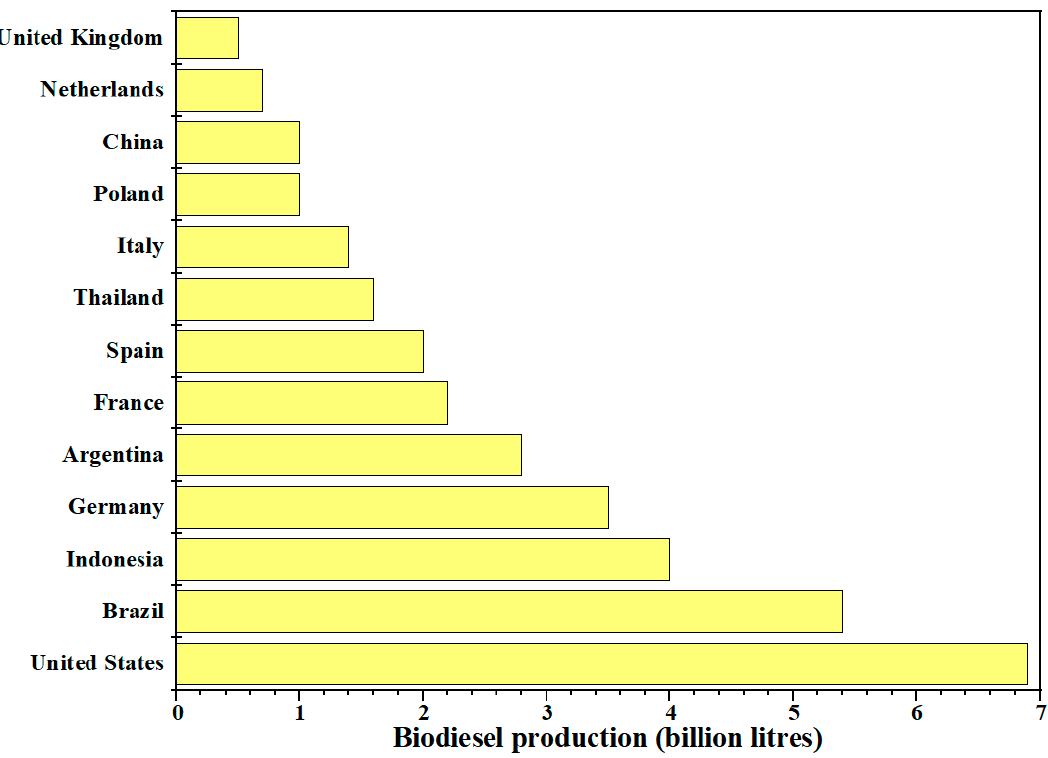
Figure 4. Top countries on biodiesel production.